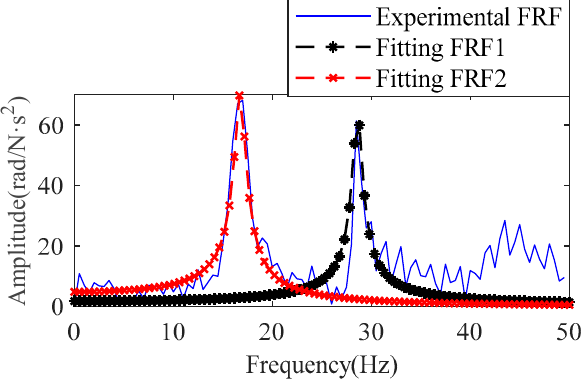
Figure 18. Two single-degree-of-freedom systems.